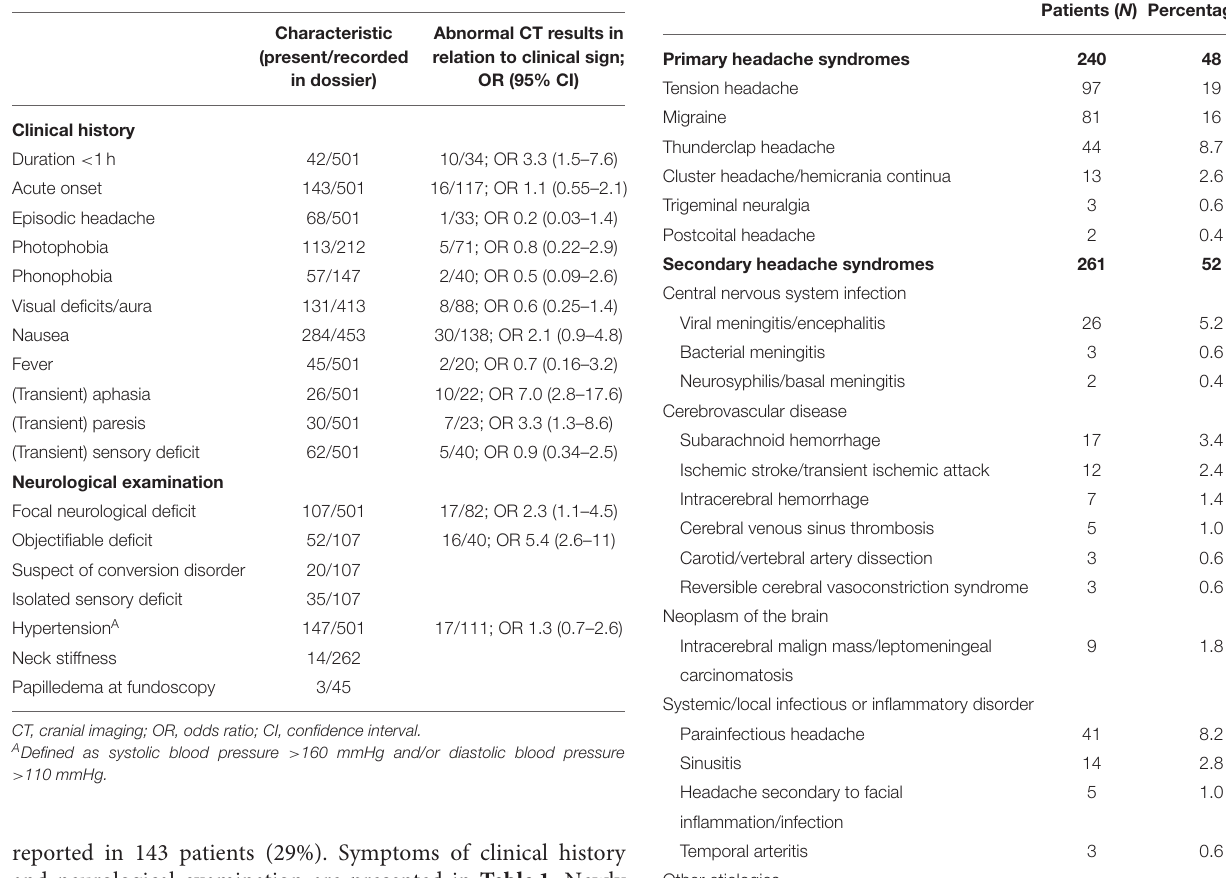
TABLE 2 | Diagnoses/headache